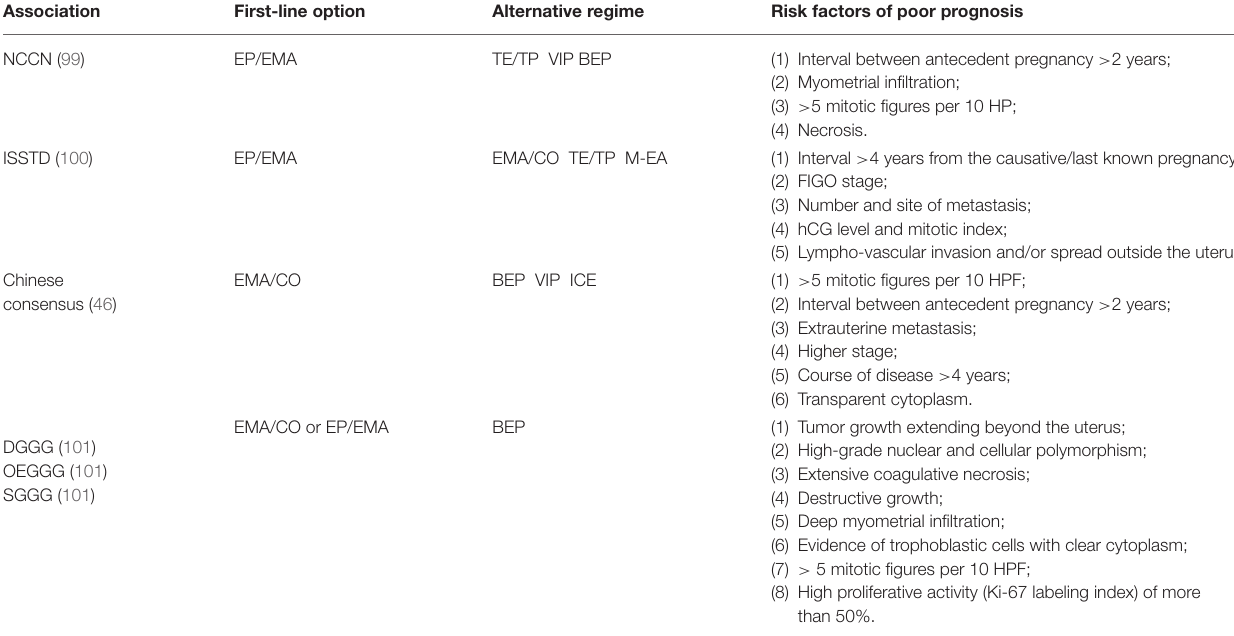
TABLE 5 | Recommended treatment of PSTT in published guidelines.